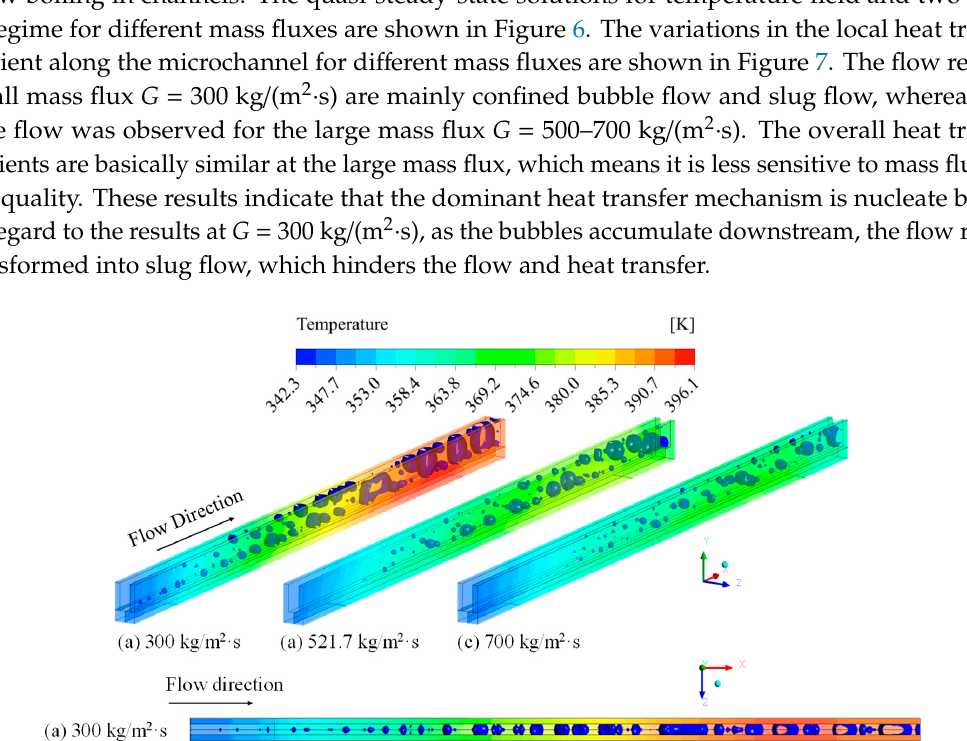
Figure 7. Variations in the local heat transfer coefficient along the flow stream for different mass fluxes. 3.3. Effect of Channel Height on the Flow Boiling In microchannels, the accumulation and growth of bubbles downstream of the channel can seriously impede the flow boiling heat transfer. The channel dimension has a significant influence on the distribution of bubbles whereas changing the heat transfer area. The effects of channel height on flow boiling in microchannels at G = 700 kg/(m 2 ·s) for the cross-section of 0.2 × 0.5 mm, 0.2 × 1.0 mm and 0.2 × 2.0 mm are investigated in the present study. The quasi-steady-state solutions of the temperature field and two-phase flow regime for different channel heights are shown in Figure 8. The temperature distribution of the heating wall and channel bottom wall along the flow direction is shown in Figure 9. It can be found that the height of the channel has a great influence on the bubble growth and the temperature distribution. The temperature of the heating wall and the channel bottom wall gradually decreases with the increasing channel height, and the temperature distribution also becomes more uniform.